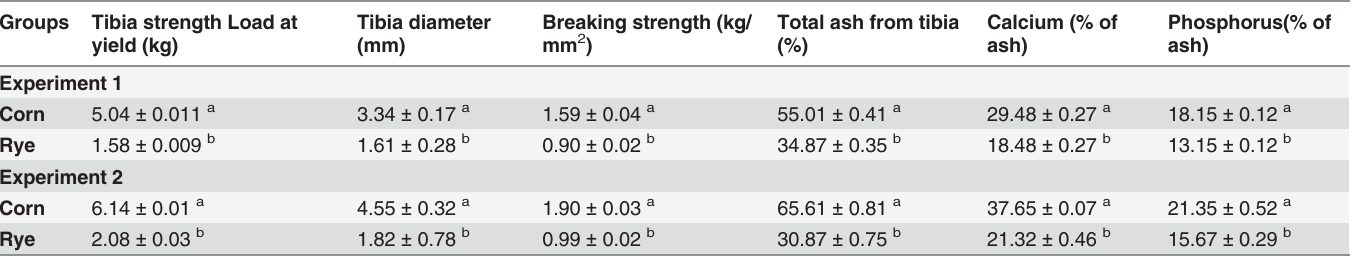
Table 4. Evaluation of bone breaking strength and bone parameters in turkey poults fed with corn or rye in Experiments 1 and 2. Groups Tibia strength Load at yield